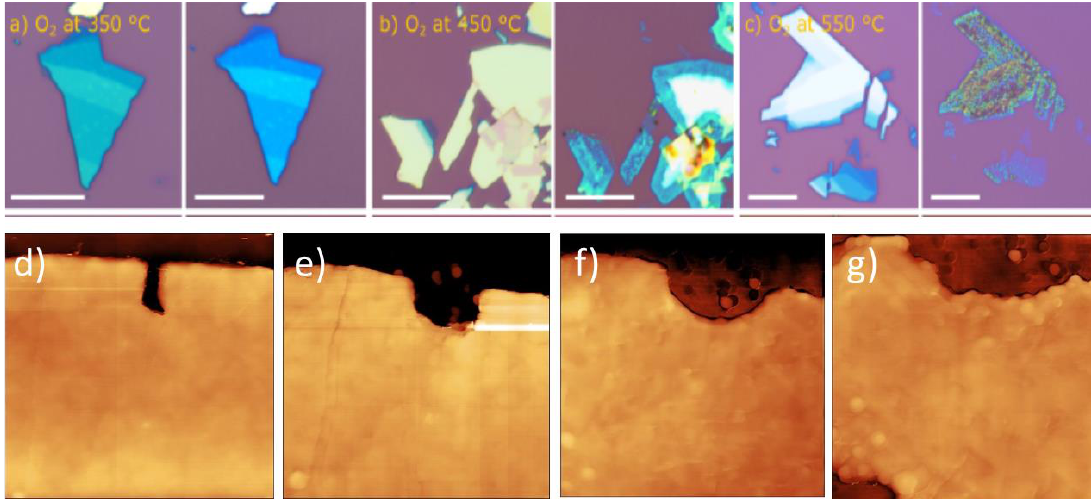
Figure 11. Substantial shrinking of the single MoS 2 flakes after rapid thermal oxidation in air above 400 ◦ C. (Color online) ( a – c ) Optical images of the before (left) and after (right) examples of oxidized flakes previously mechanically exfoliated on Si substrates and annealed in Ar to remove scotch tape contaminants, all flakes heated for 20 min at O 2 . ( a ) At 350 ◦ C, not much etching/oxidation was observed. ( b ) At 450 ◦ C. ( c ) At 550 ◦ C. In each image, the darker regions of each flake are 5–10 layers of MoS 2 (3.2–6.5 nm), which etch at similar rates. All scale bars are 10 µ m. ( d – g ) 5 µ m × 5 µ m AFM LFM images (for better contrast) of a single ca. 20 nm–thick MoS 2 flake on silica/silicon substrate [77]. The images were collected at room temperature after progressive heating of the sample in air at temperatures and times provided: ( d ) 370 ◦ C at 10 min, ( e ) 400 ◦ C at 5 min, ( f ) 410 ◦ C at 5 min and ( g ) 420 ◦ C at 5 min. Parts ( a – c ) are reprinted from Reference [36], with permission. Copyright 2017, American Vacuum Society; parts ( d – g ) are adapted from Reference